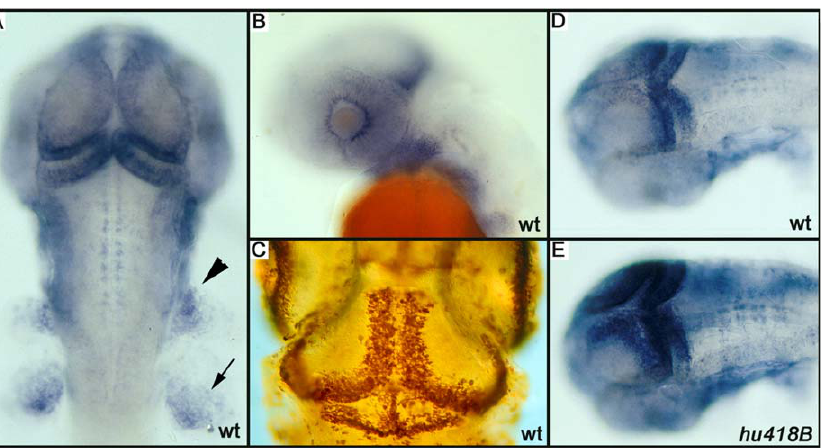
Figure 1. PCNA and Proliferation Patterns (A) PCNA pattern as scored during the screen. In a dorsal view at 40 hpf, PCNA staining is observed in the medial and posterior part of the tectum, and in the cerebellum, the neural crest (arrowhead), and the pectoral fin (arrow). (B) In a sideview (42 hpf), a ring of positive cells is visible around the lens. (C) In a whole-mount BrdU labeling from day 3.5 to 4.5, similar regions are labeled indicating that PCNA RNA expression prefigures where BrdU will be incorporated. (D and E) Sibling and hu418B mutants, respectively, showing increased PCNA labeling in the CMZ, but most prominently in the tectum. DOI: